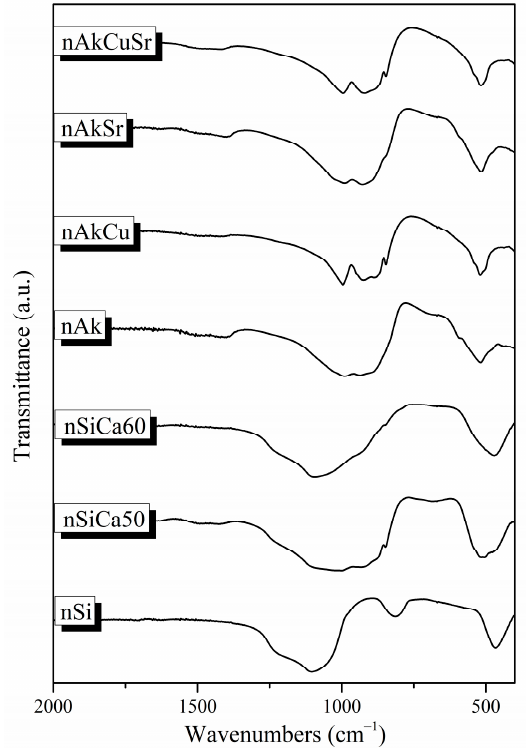
Figure 2. FTIR spectra of the synthesized nanobioceramics.